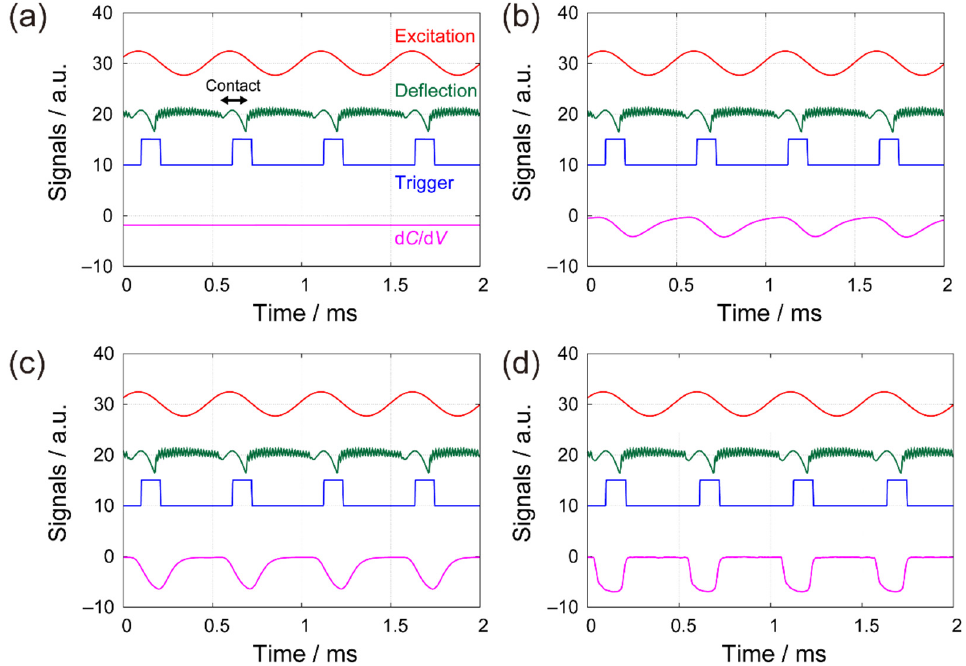
Figure 7. Time series data of the cantilever excitation (solid red curve), cantilever deflection (green), trigger (blue), and d C /d V signal (pink) for different time constants of the lock-in amplifier ( a ) τ 1 = 435 µ s ( b ) τ 1 = 43.5 µ s ( c ) τ 1 = 21.7 µ s ( d ) τ 1 = 4.35 µ